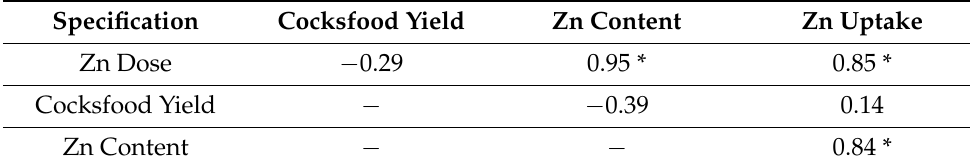
Table 9. Linear correlation coefficients between selected properties of